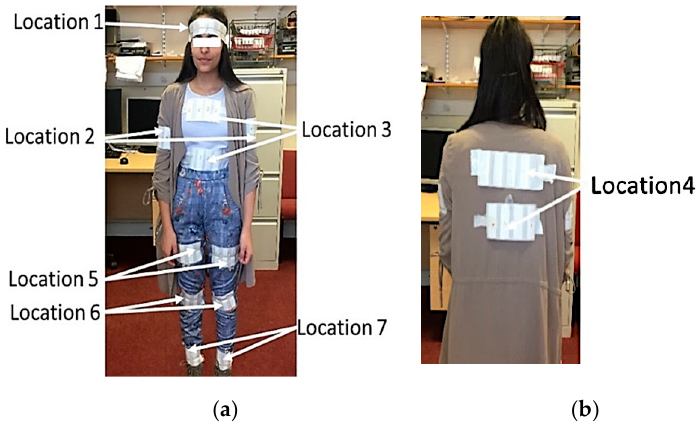
Figure 1. ( a ) Front and ( b ) back view of tag placement on target in a standing position.